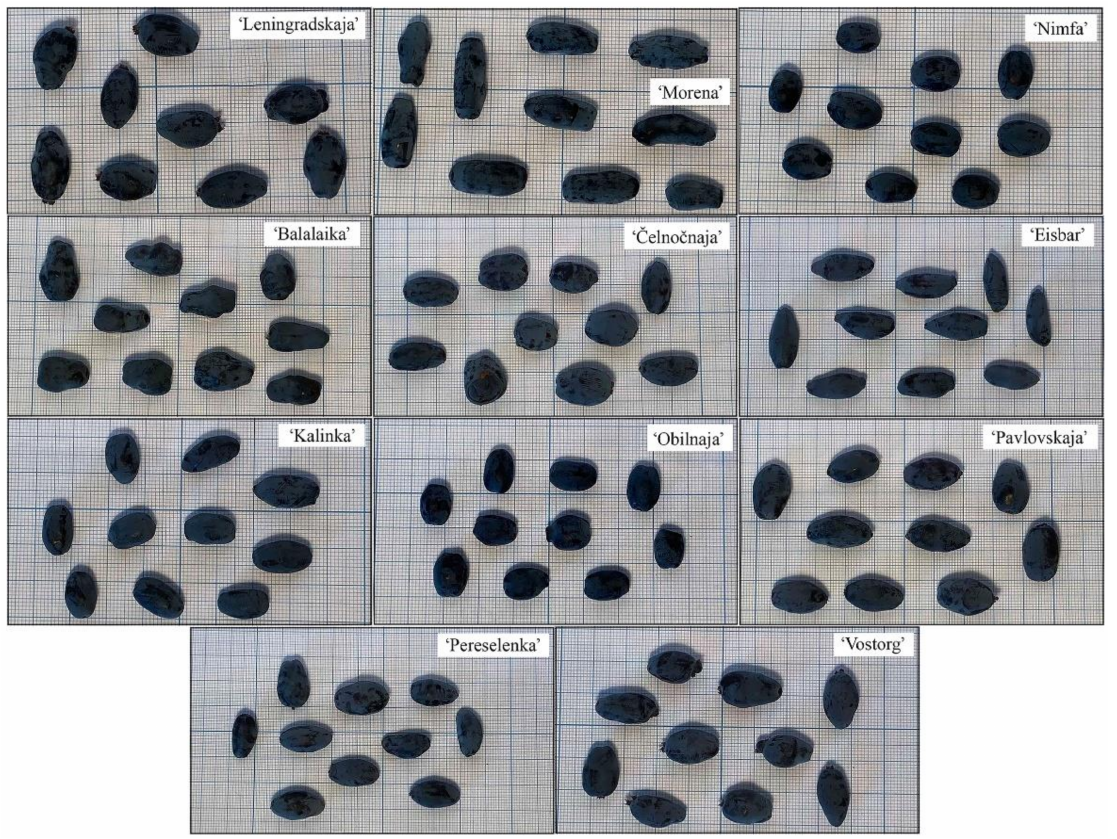
Figure 1. Berry shape and relative size of Lonicera caerulea cultivars at the stage of full